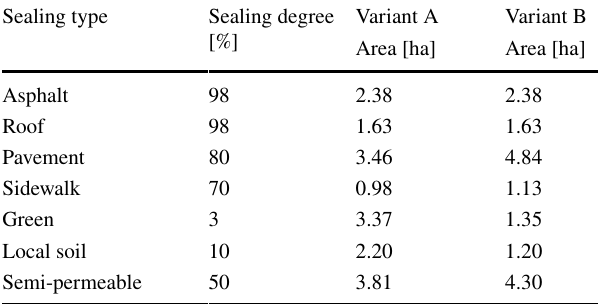
Table 2 Characteristics of accepted rainfall events (Musz-Pomorska et al. 2019; Chmielewska et al. 2013; Widomski et al. 2012) Variant Time duration of rainfall event [h]